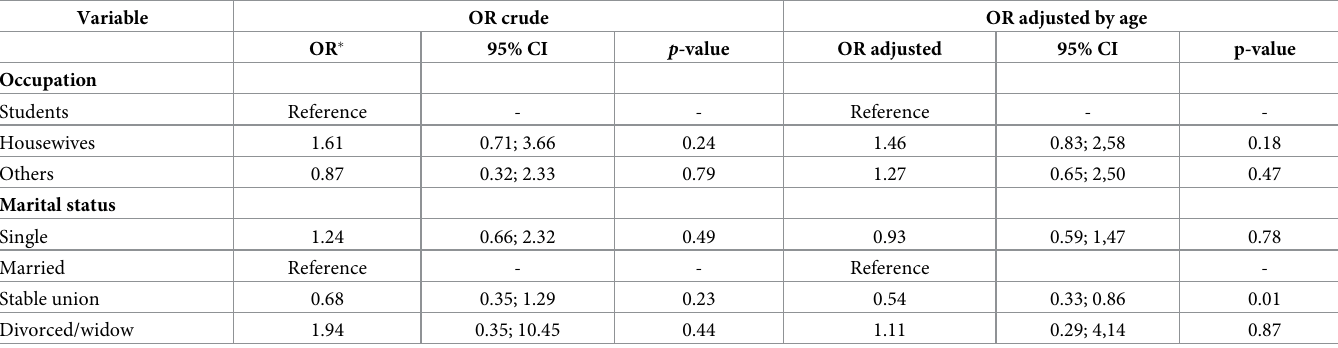
Table 3. Analysis of crude and age-adjusted odds ratio of socio-demographic variables of pregnant women with epilepsy. Variable OR crude OR adjusted by age OR � 95% CI p -value OR adjusted 95% CI